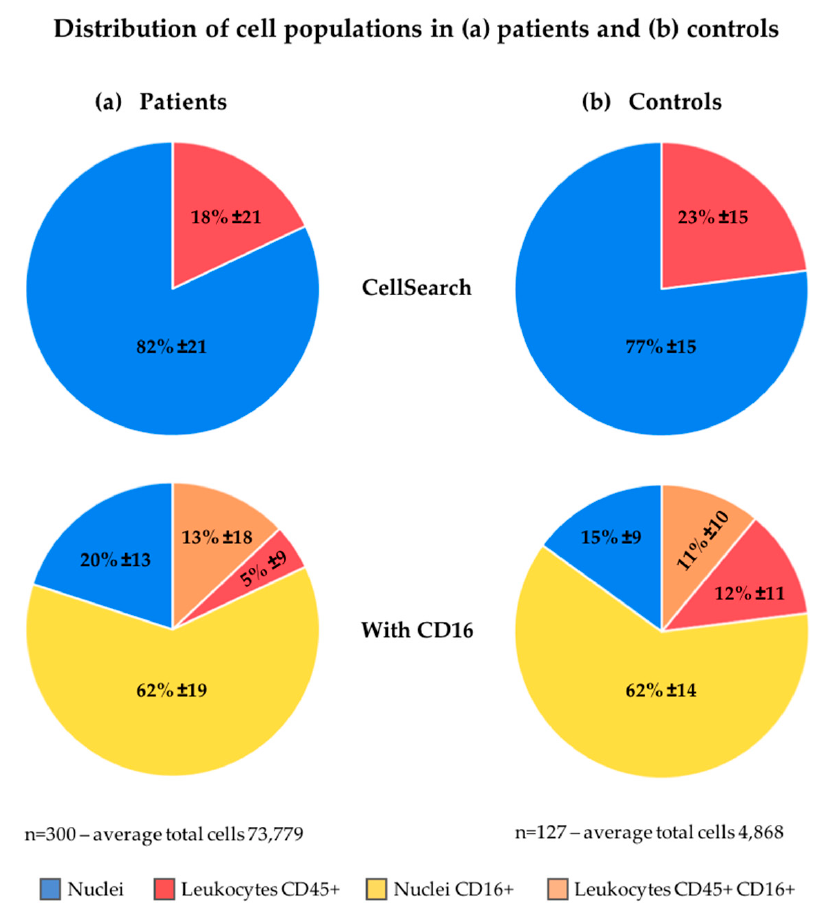
Figure 3. Cell population distribution in ( a ) patients and ( b ) controls using the CellSearch definition ( upper ) and using CD16 expression ( lower ) for further classification of the cells.